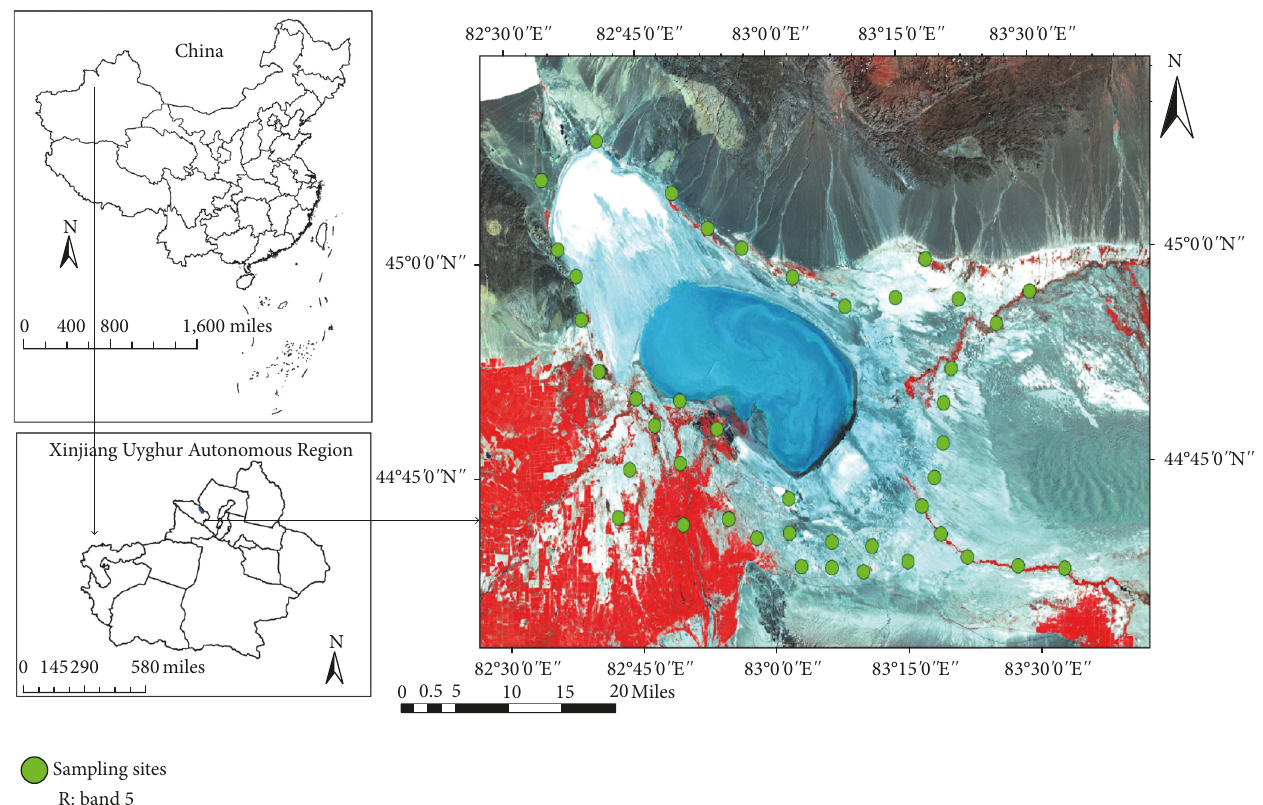
Figure 1: Study area and distribution of sampling